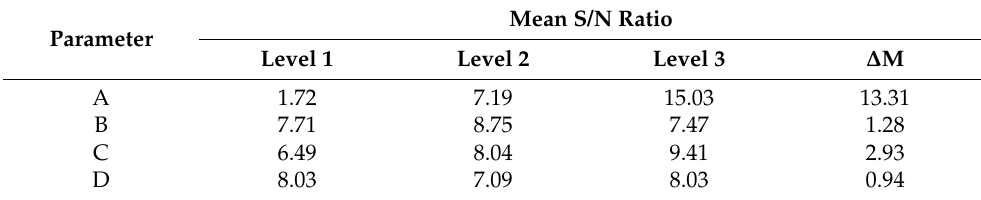
Table 7. S/N response for graphite content in the